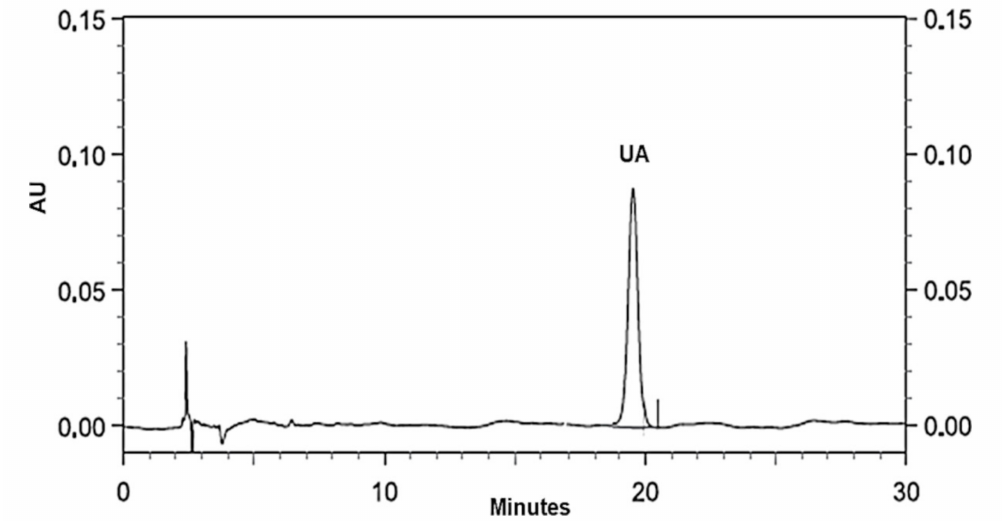
Figure 8. UA peak by high-performance liquid chromatography (HPLC) analysis.